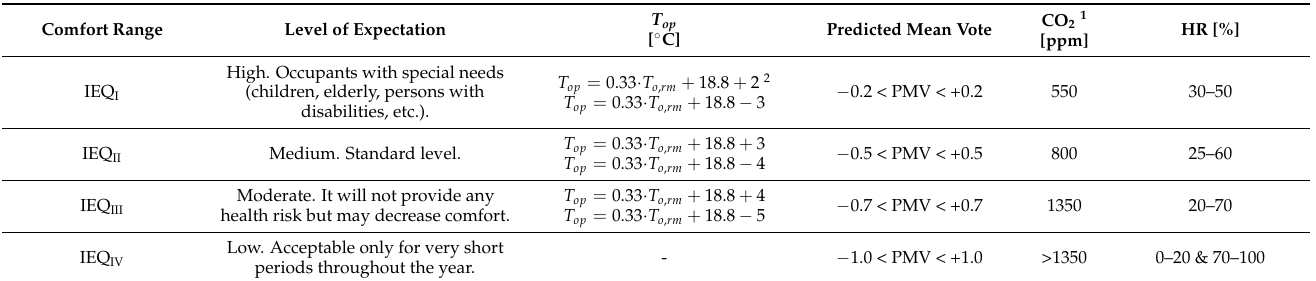
Table 2. Comfort range for the different comfort indexes: Operative temperature, CO 2 concentration and HR levels